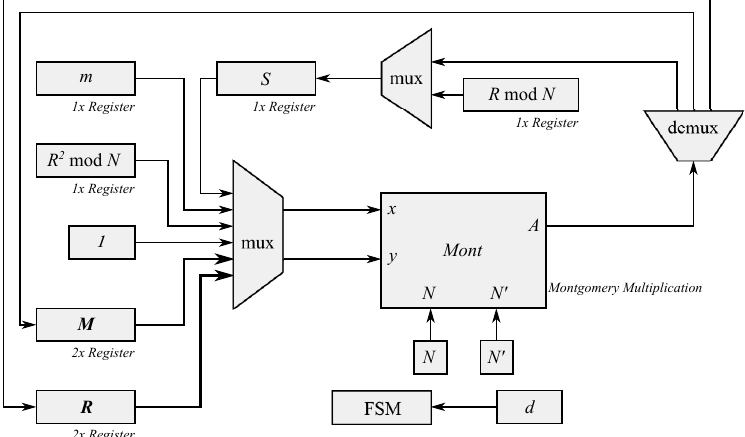
Figure 3. Block diagram of the proposed Modular